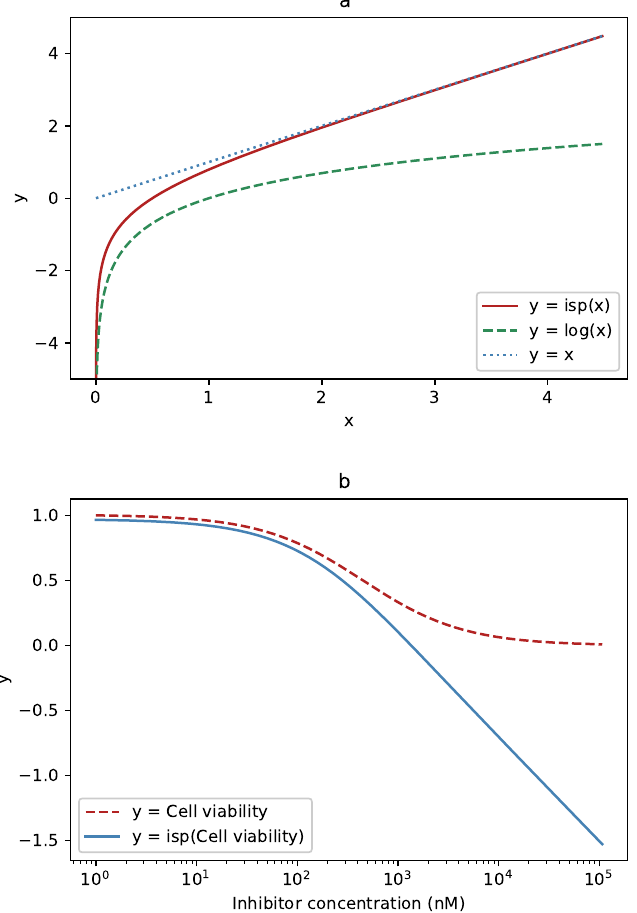
Figure 2. The function used to transform the data and its effect on the Hill curve: ( a ) For low values, close to zero, the inverse softplus function (solid, red) approximates the logarithm (dashed, green). For high values, it approaches the identity line, y = x (dotted, blue). ( b ) Where the logistic (Hill) function (dashed, red) has high values, the inverse softplus (solid, blue) leaves it almost unchanged. At low values, where the logistic function becomes close to a falling exponential, the inverse softplus transforms it to an almost straight